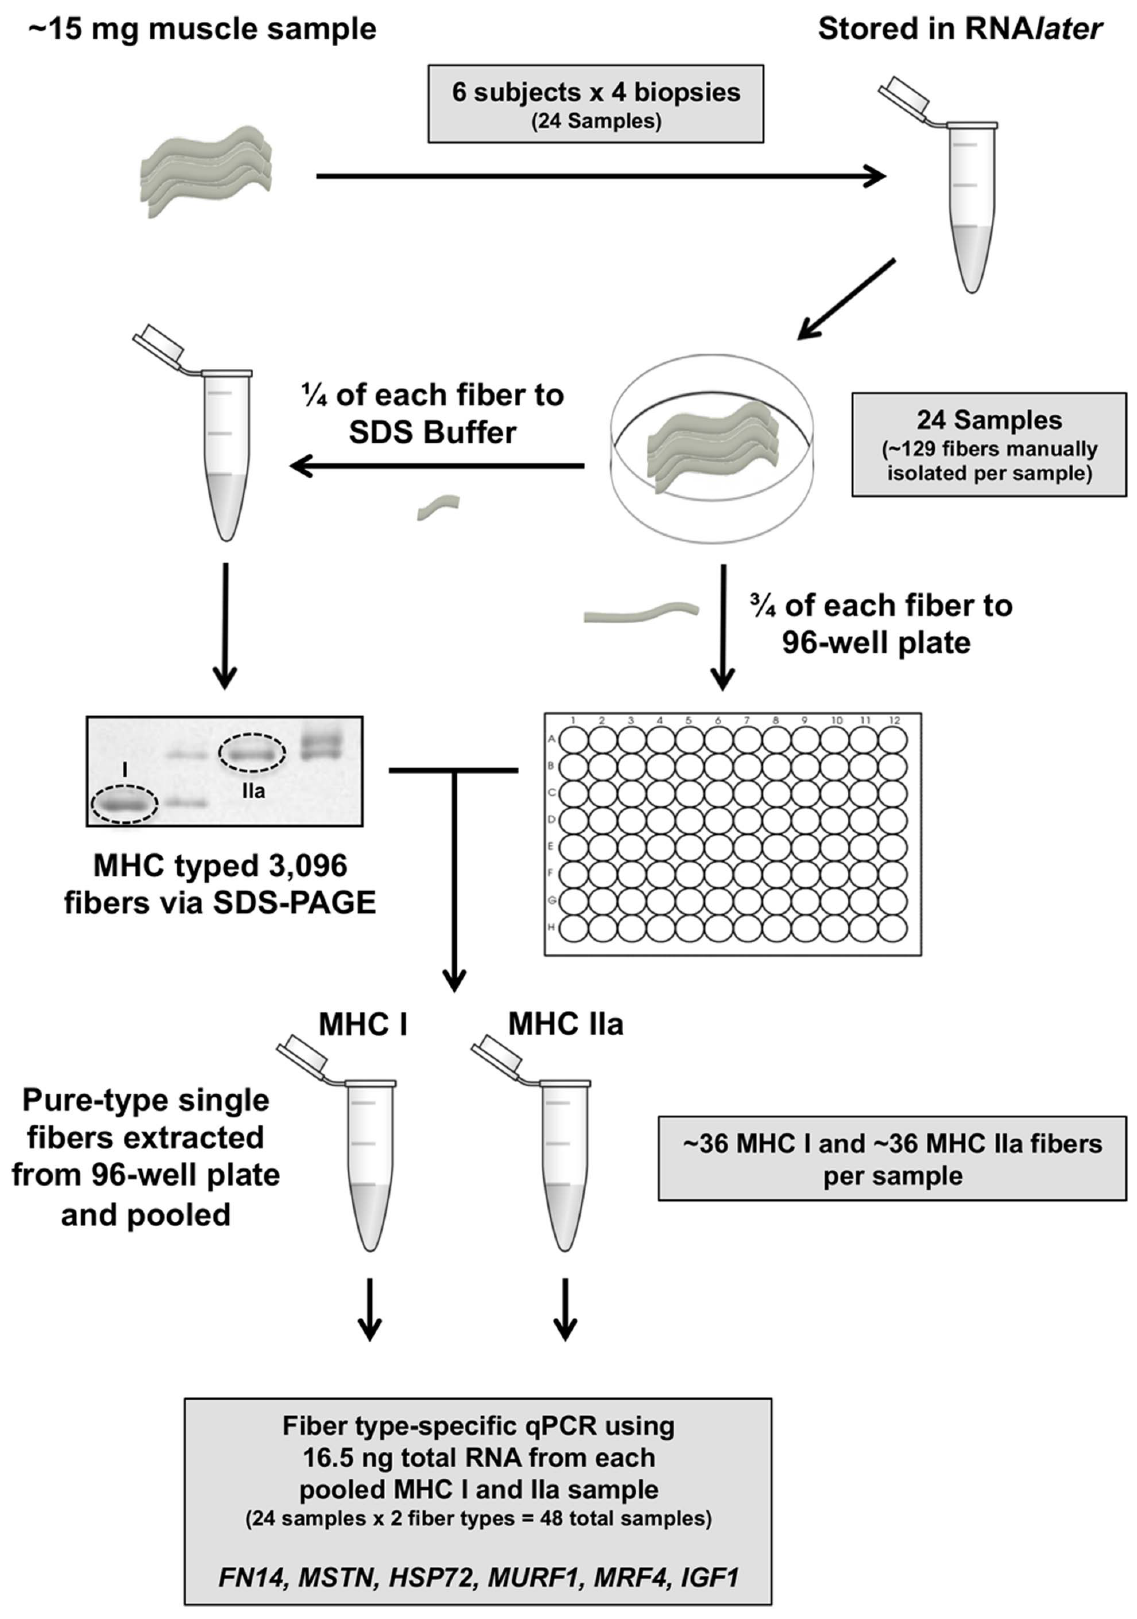
Figure 3. Schematic of method used to conduct fiber type-specific isolation of single muscle fibers for qPCR analysis.